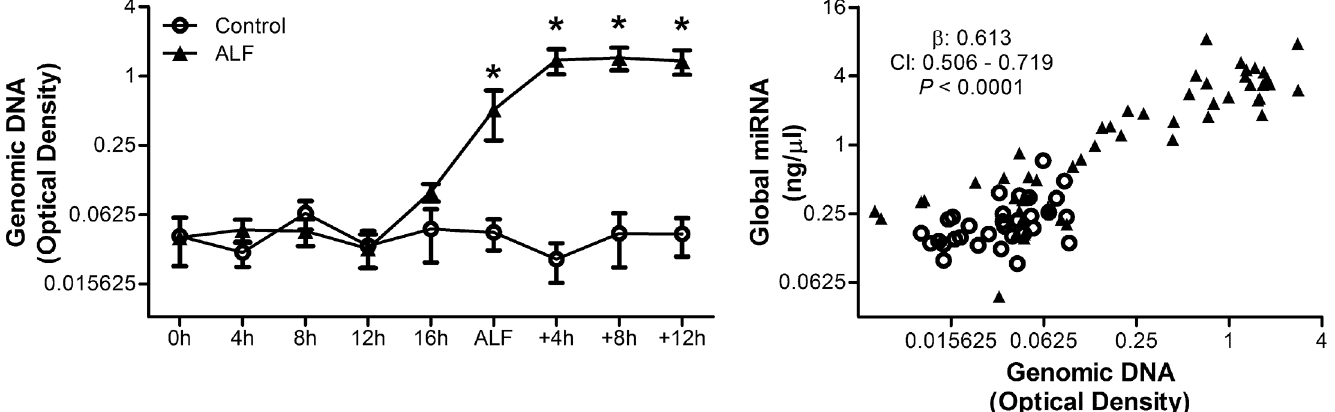
Fig 3. Increasing plasma global miRNA concentrations associate with increasing plasma genomic DNA in APAP-treated animals. Genomic DNA levels were measured in APAP treated pigs (n = 6) and controls (n = 3), and its association with global miRNA concentrations was assessed. Values are means ± SE; * P < 0.05 vs. baseline at -20h; β : fixed effects; CI: confidence interval.